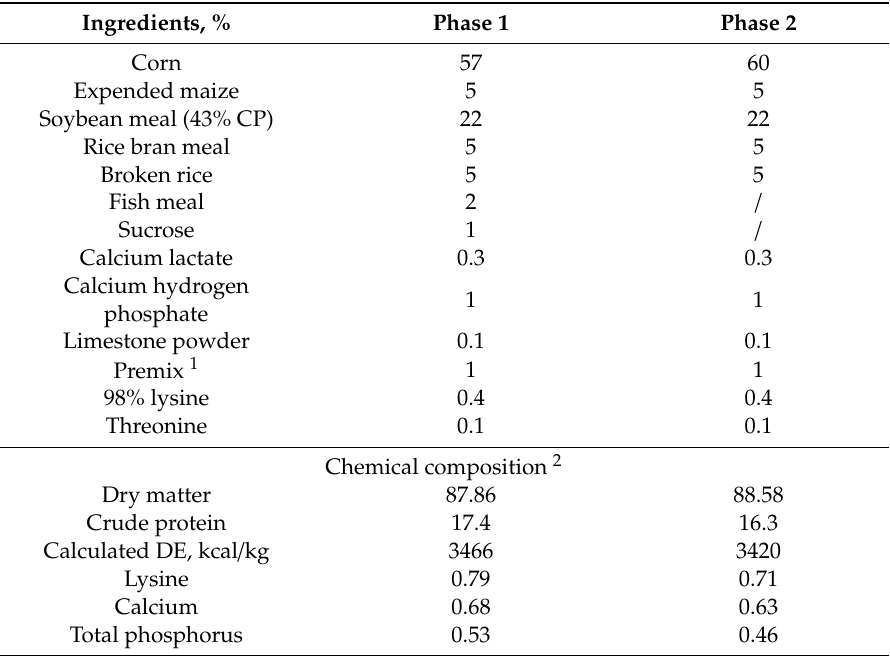
Table 1. Composition of basal diets (as-fed